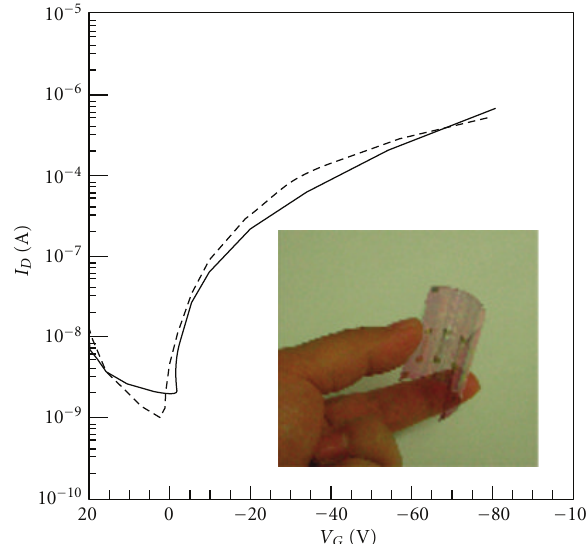
Figure 8: Transfer characteristics of P3HT TFT fabricated on glass substrate (solid line) and PEN substrate (dashed line) at V D = − 80V. Inset: An image of TFT device on PEN substrate (5 × 5cm 2 ).